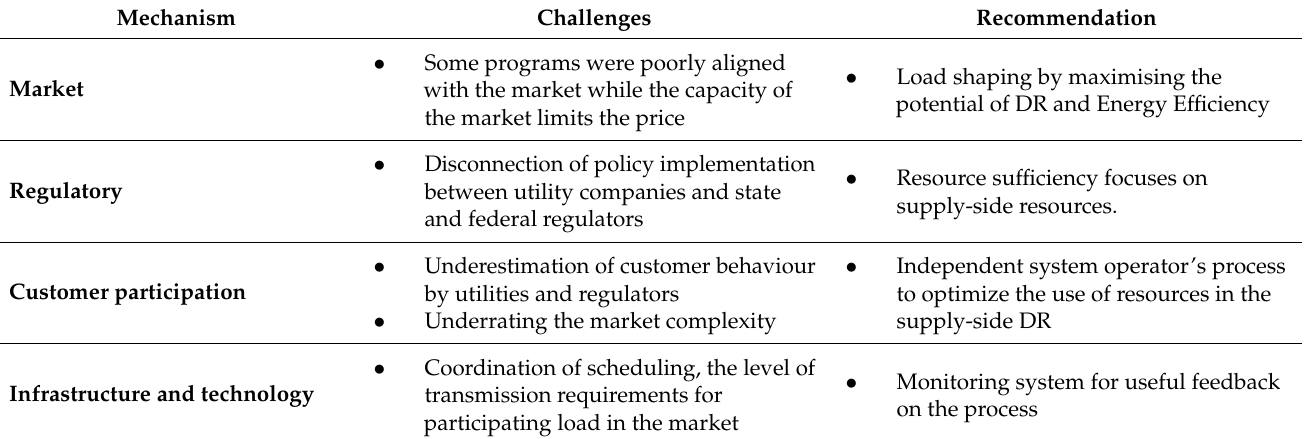
Table 2. The barriers hindering the DR programme and the recommendation by CASIO for a properly configured DR